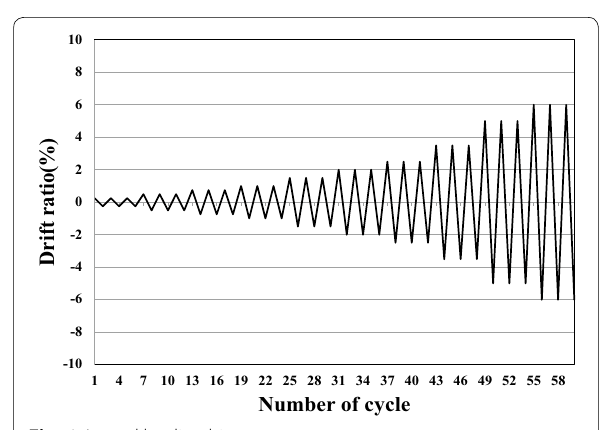
Fig. 6 Lateral loading